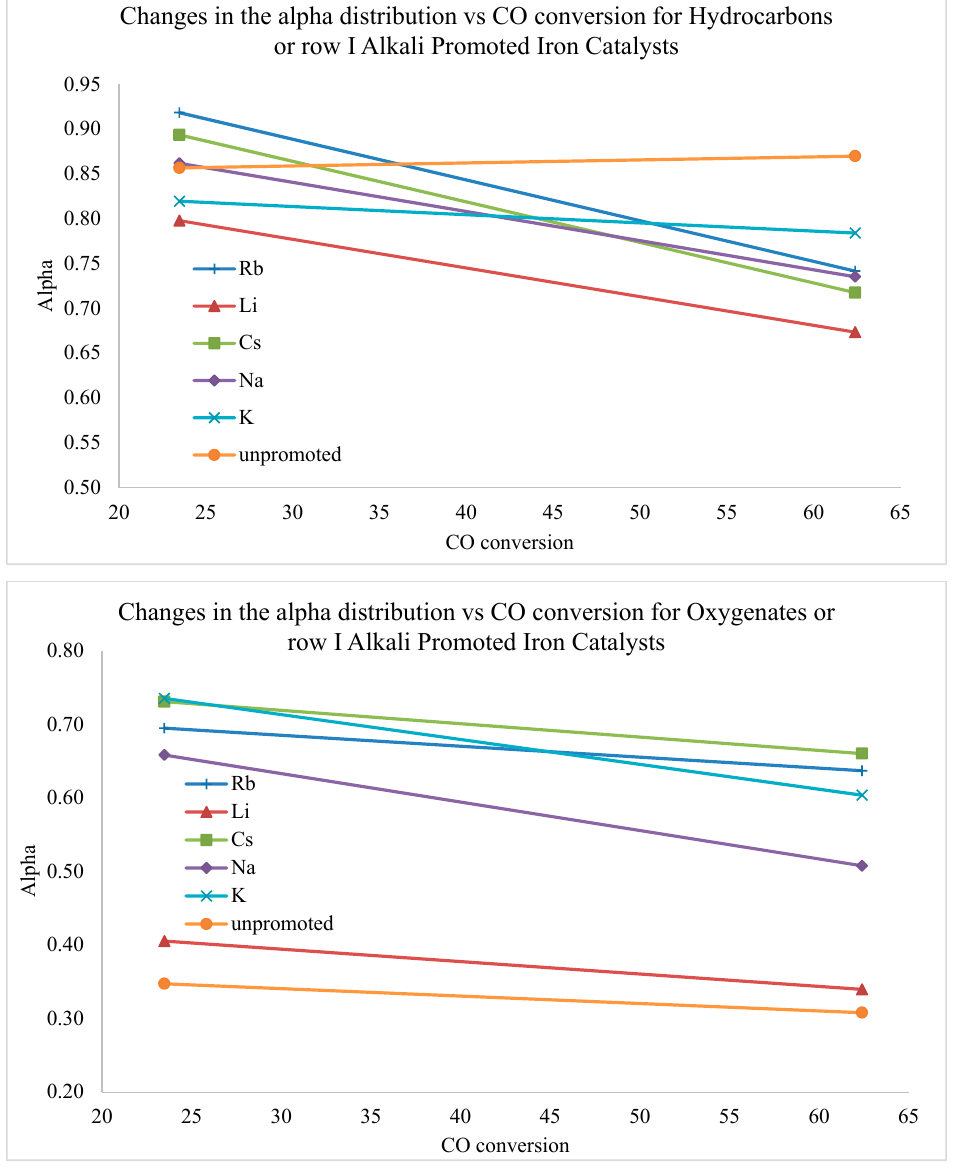
Figure 51. Changes in the alpha vs. CO conversion for Group I promoted iron catalysts. Reactor Conditions: 270 °C, 12.1 bar, WHSV = 2, and H 2 /CO = 0.7.